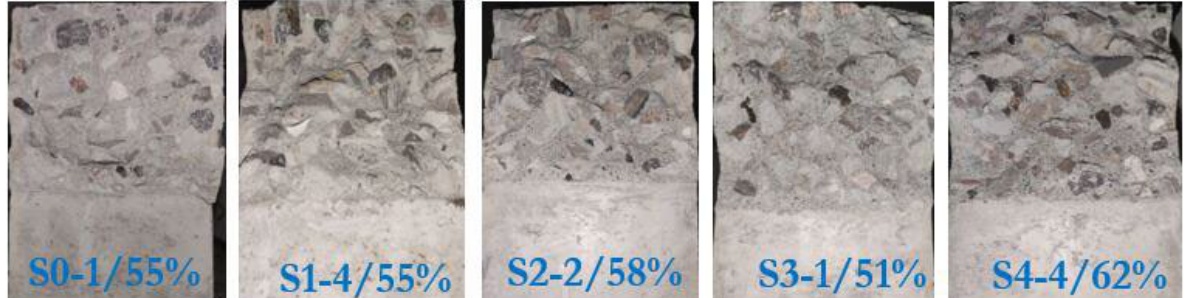
Figure 5: Typical fracture cross section of three-point bending beams.